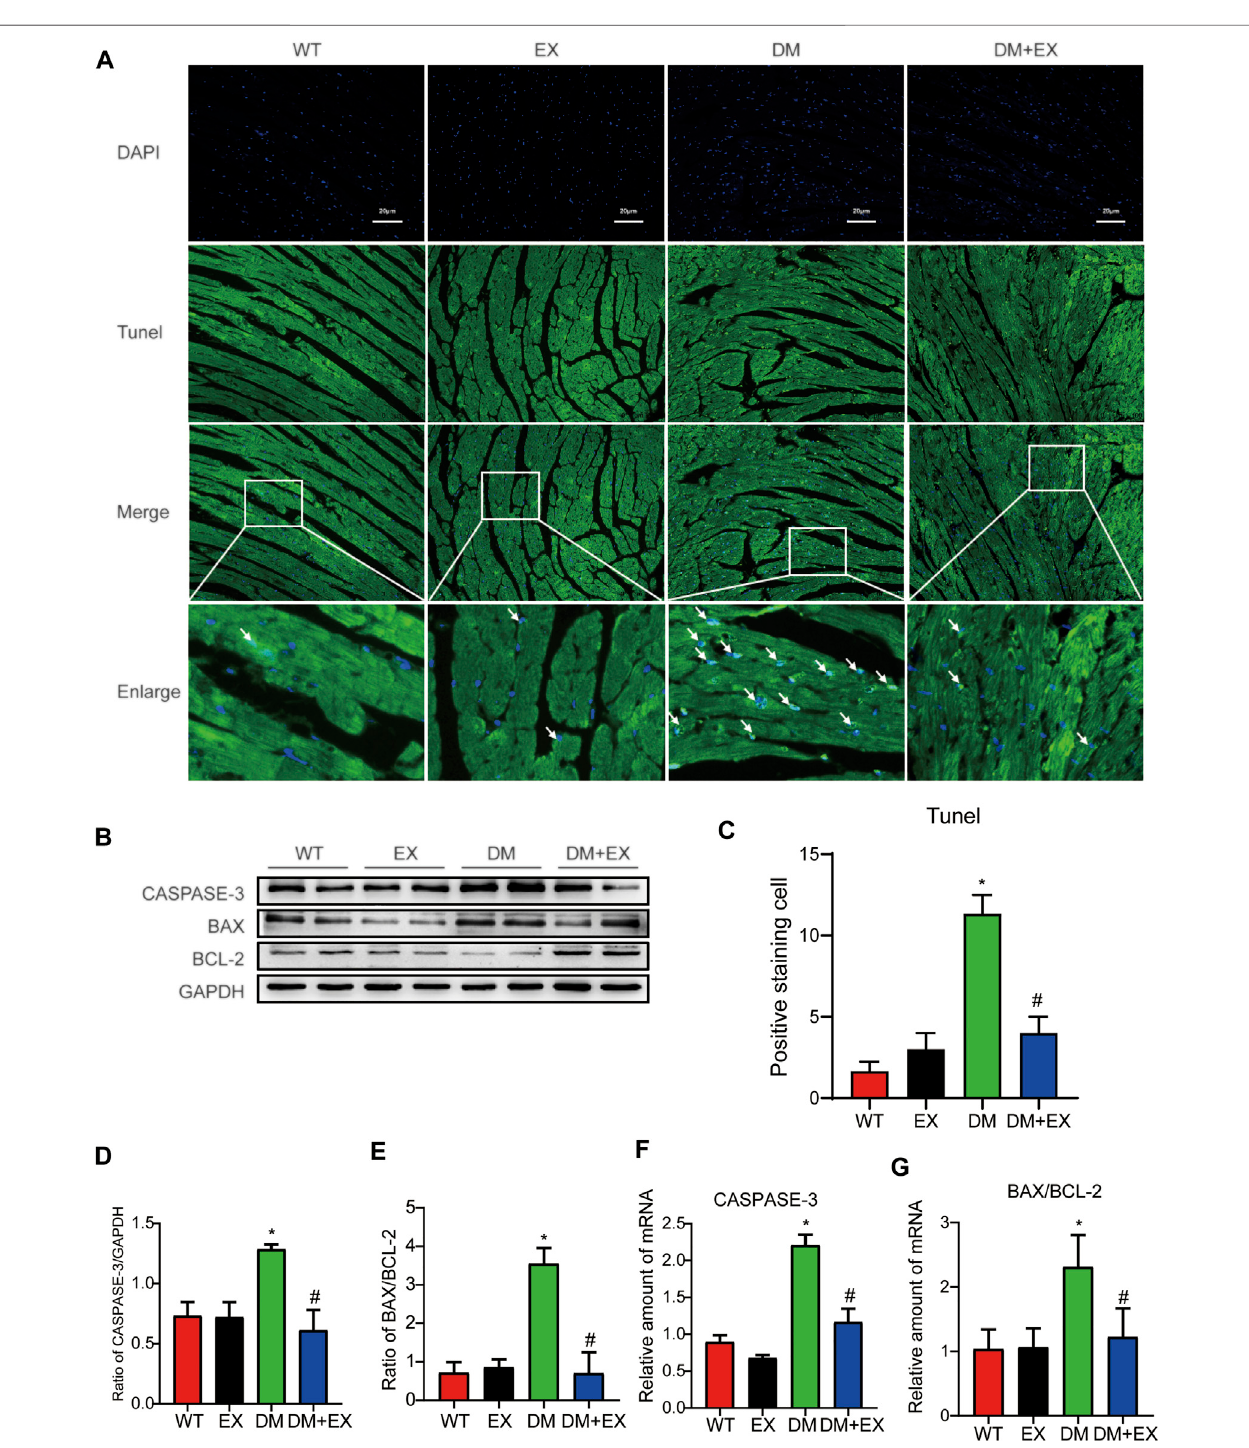
FIGURE5| ExercisealleviatedcardiomyocyteapoptosisinHFD+STZ-inducedT2DMmice. (A,C) TUNELstainingandquantitative analysisofmyocardialtissuein mice; (B,D,E) Westernblot analysiswasperformedtodetect apoptosis-related proteins (Caspase-3 and Bax)and anti-apoptoticprotein (Bcl-2); (F,G) Geneexpression of apoptosis-related proteins. * p < 0.05 vs. the WT group, # p < 0.05 vs. the DM group.